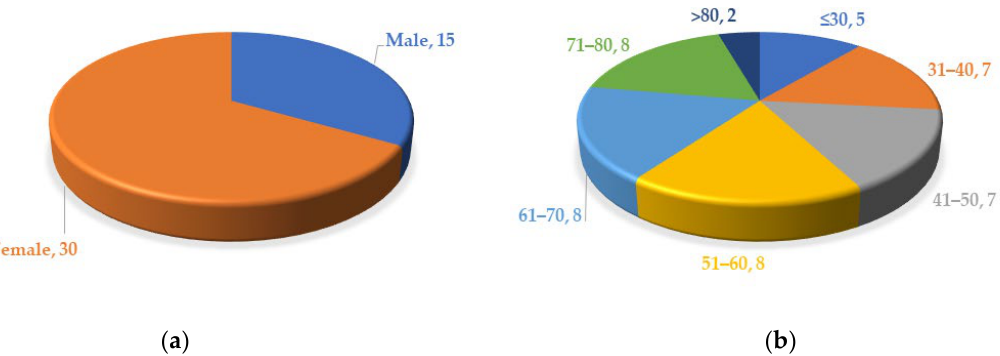
Figure 2. ( a ) Gender distribution of patients with arthritis; ( b ) age distribution of patients with arthritis.